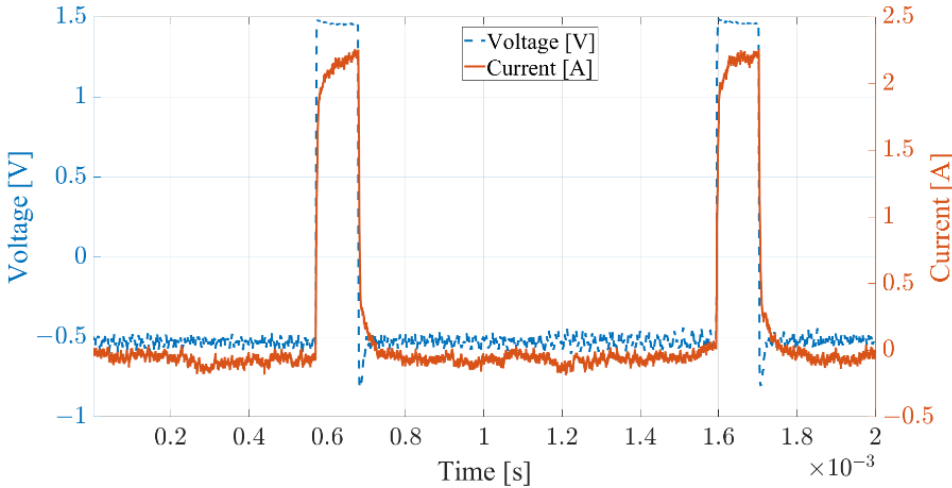
Figure 2. Power output of laser driver.